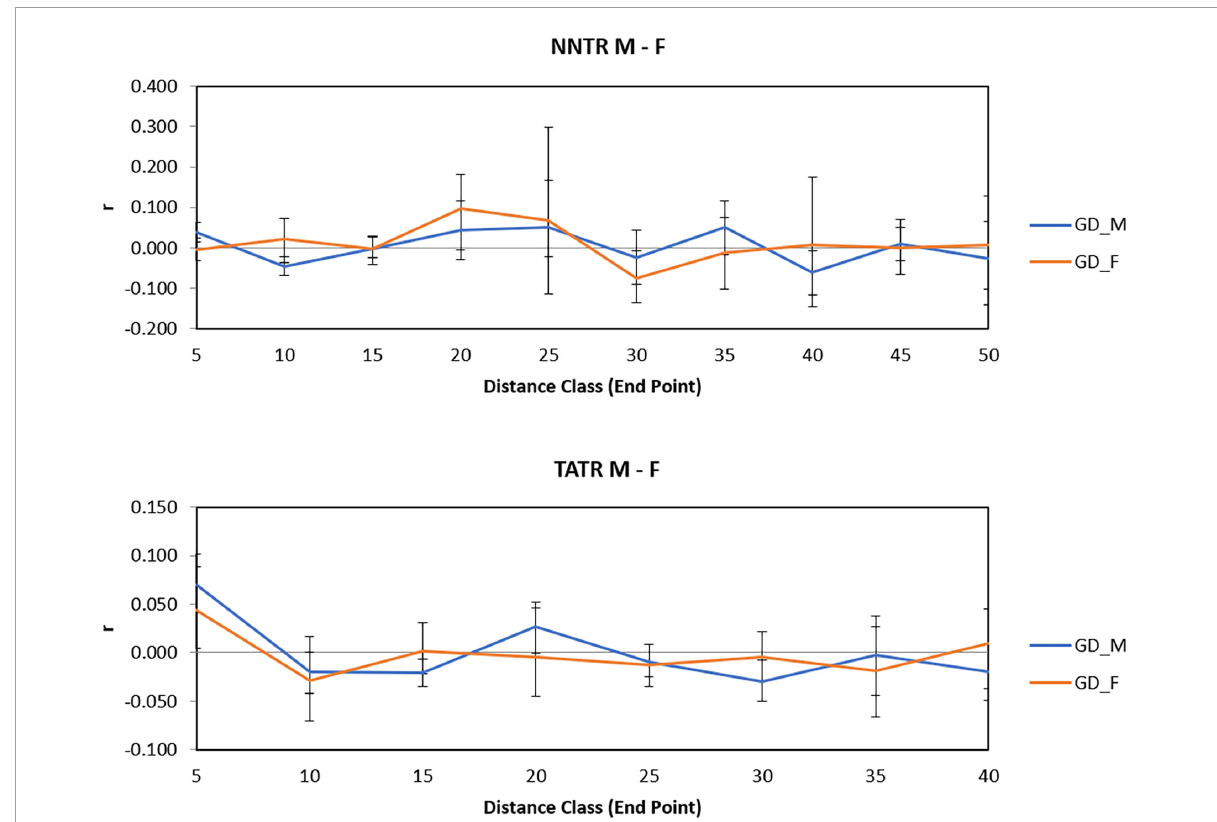
FIGURE4 Spatial genetic structure correlograms for Nawegaon-Nagzira Tiger Reserve (NNTR) M and F and Tadoba-Andhari Tiger Reserve (TATR) M and F.